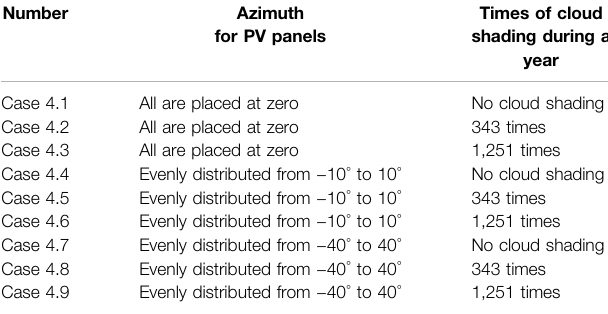
TABLE 7 | Case settings for the synthetic